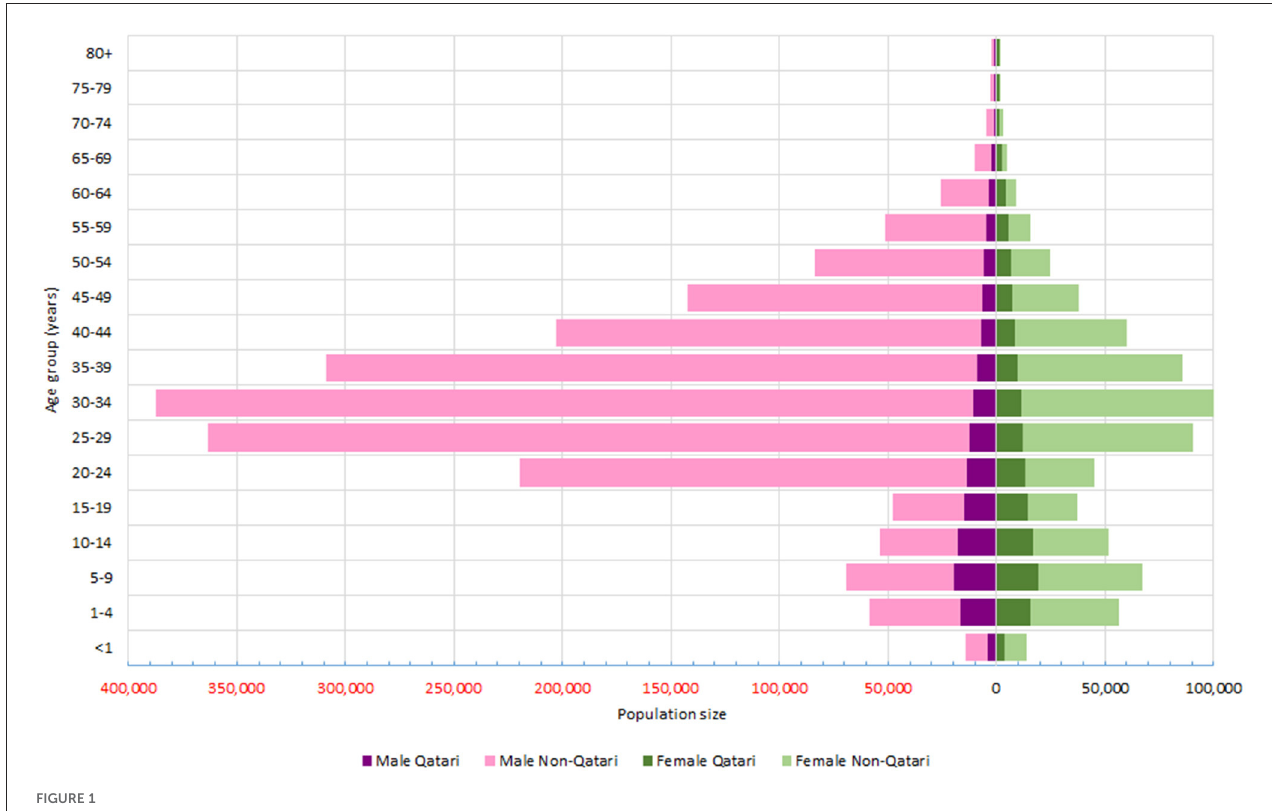
FIGURE1 Population pyramid of Qatar by sex, age groups and nationality